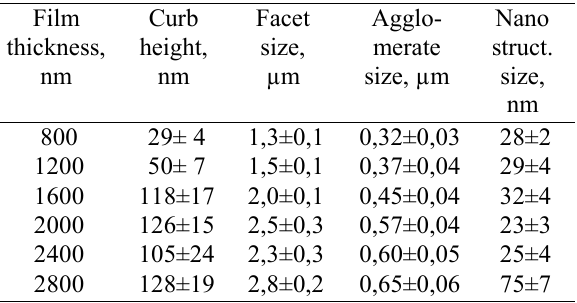
Table 1: Dimensions of the elements of the